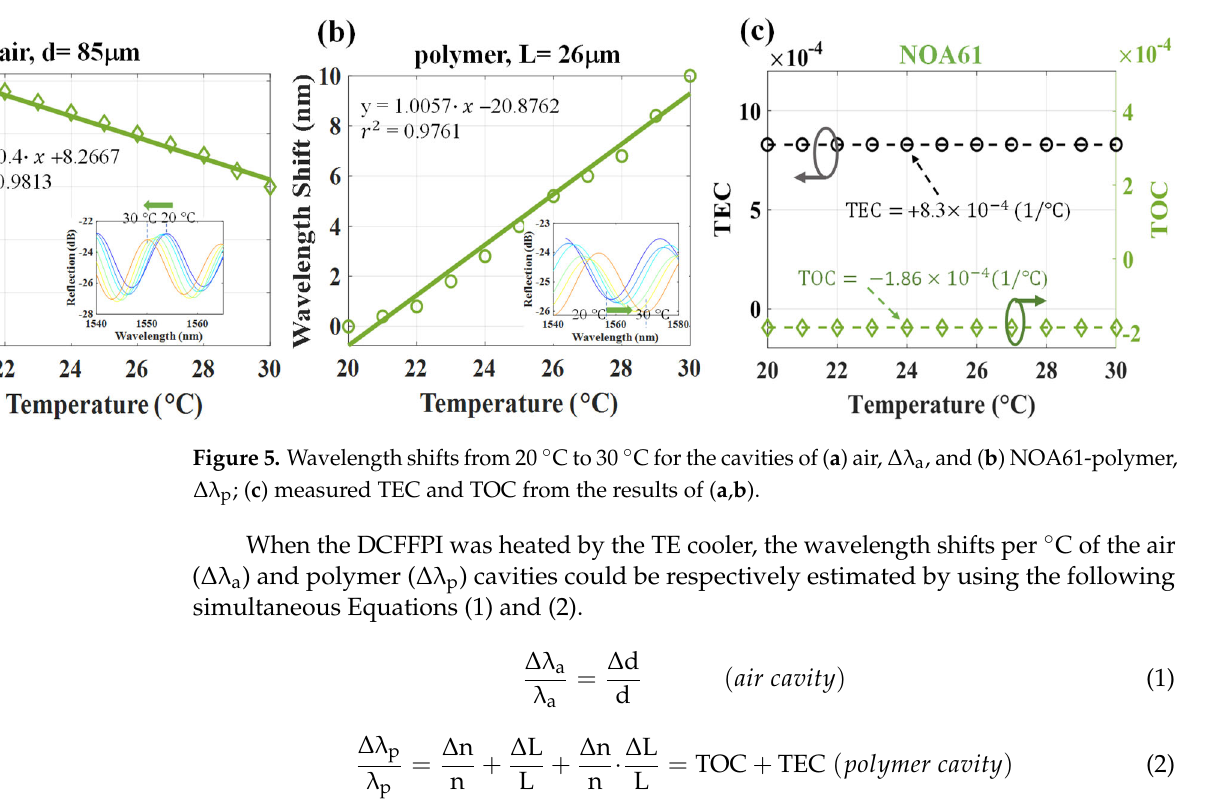
Figure 6. Wavelength shifts from 20 °C to 30 °C for the cavities of ( a ) air, ∆λ a , and ( b ) NOA65 ‐ polymer, ∆λ p ; ( c ) measured TEC and TOC from the results of ( a , b ).